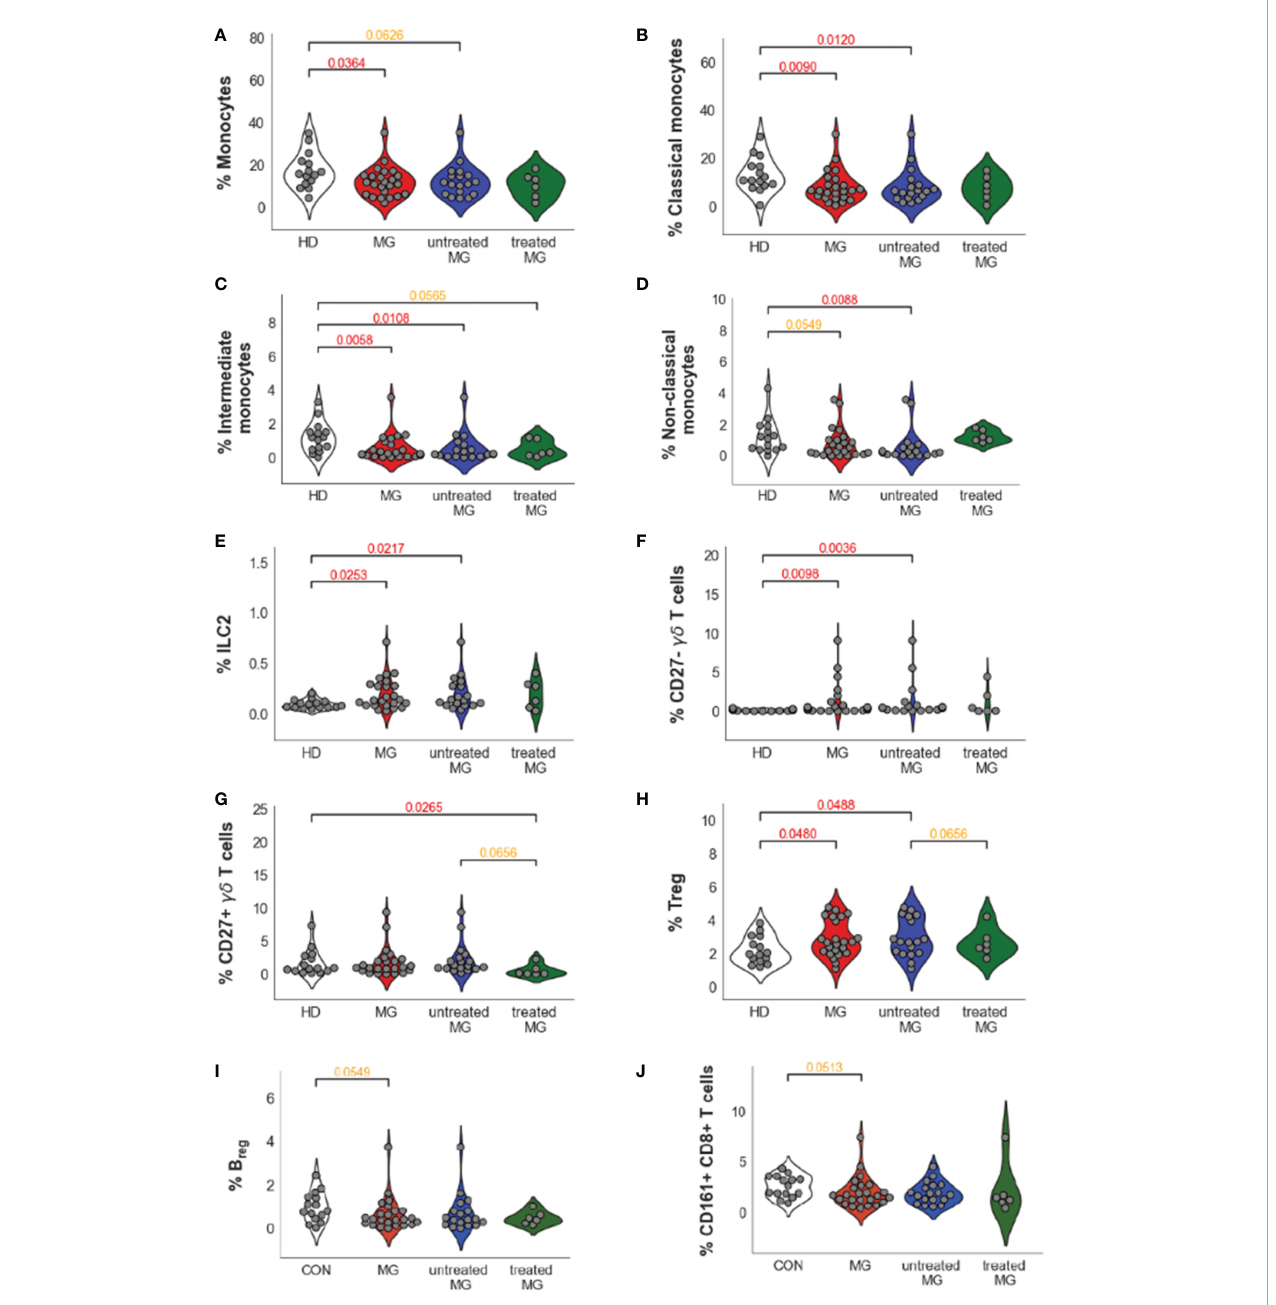
FIGURE 4 Impact of the treatments on cell percentage for dysregulated cells in AChR MG. Distribution of cell population percentages and differences between healthy donors (HD), all MG patients (MG), and separately for untreated and treated MG patients for all monocytes (A) , classical (B) , intermediate (C) , and non-classical (D) monocytes, ILC2 (E) , CD27 - (F) and CD27 + (G) gd T cells, Treg (H) and Breg (I) cells and CD161 + CD8 + T cells (J) . p values were determined by the Mann-Whitney test (two-tailed) for non-parametric analyses. p values were indicated when p <0.05 (in red) and 0.1 (in